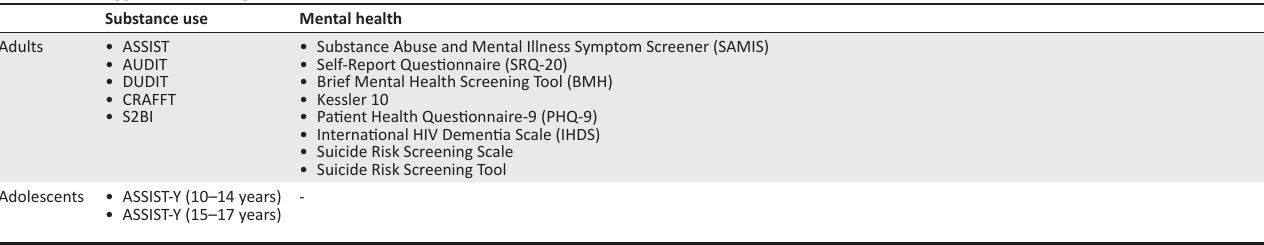
TABLE 1-A4: Suggested screening tools.